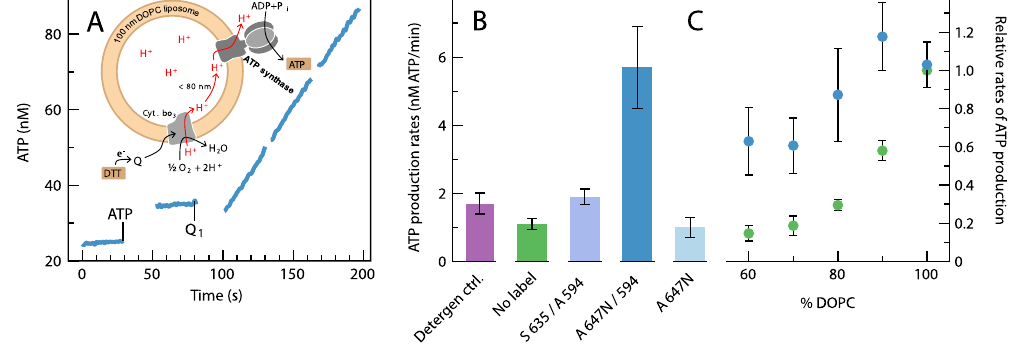
Figure 6. Coupled cyt. bo 3 -ATP synthase activity. ( A ) ATP production by the ATP synthase, driven by an electrochemical gradient generated by cyt bo 3 (as shown in the scheme). ATP synthesis was measured as a change in luminescence from the luciferin-luciferase couple over 3 × 30 s. The reactions were started by the addition of ubiquinol Q 1 H 2 (20 μ M final concentration) in the presence of 2 mM DTT and 80 μ M ADP. Measurements were done at pH 7.5 in 20 mM Tris-PO 4 buffer supplemented with 2.5 mM MgCl 2 . Rates were calculated from the average slopes, calibrated by addition of well-defined amount of ATP (5 pmol, see mark at 30 s). The trace shown was obtained with 100 nm, 100% DOPC liposomes. ( B ) ATP-synthesis rates measured in DOPC vesicles with cyt. bo 3 labeled with either ATTO (A) 647N (and unlabeled ATP synthase) or Abberior STAR 635 (and ATP-synthase labeled with ATTO 594). Rates are compared to those obtained with proteoliposomes with unlabeled cyt. bo 3 and ATP-synthase in the presence (2.5 μ M DDM, Detergent ctrl., see text for explanation) or absence (No label) of detergent. ( C ) Normalized ATP-synthesis rates of DOPC:DOPG vesicles with cyt. bo 3 and ATP-synthase labeled with ATTO 647N and ATTO 594 respectively (blue) or vesicles with unlabeled protein (green). The rates are normalized to that obtained with 100% DOPC vesicles to facilitate comparison. At 100% DOPC the activity was a factor of ~5 larger with the labeled than with the unlabeled proteins (c.f. panel B). Error bars is the standard deviation from measurements with four samples (except Detergent ctrl., two